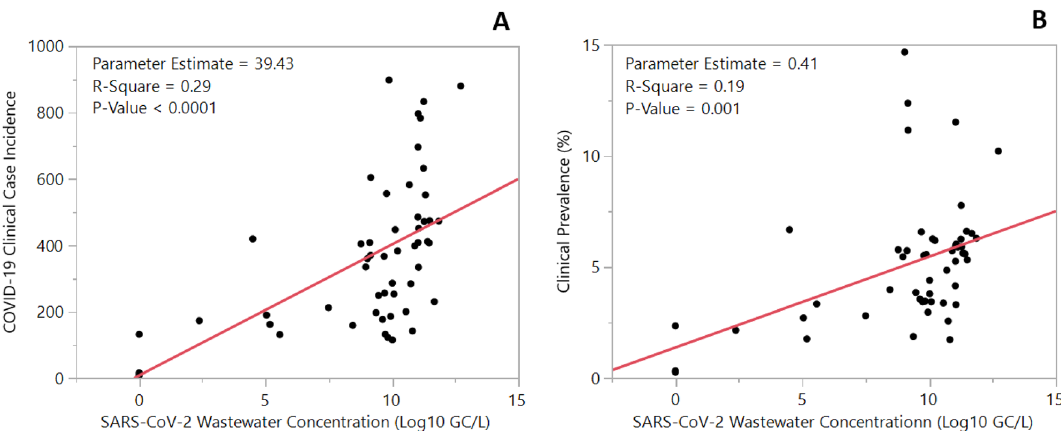
Figure 3. Linear association of the SARS-CoV-2 wastewater concentration (Log 10 GC/L) and weekly COVID- 19 clinical incidence ( A ) and weekly COVID-19 clinical prevalence ( B ) between May 26, 2020 and May 30, 2021 in Gainesville,